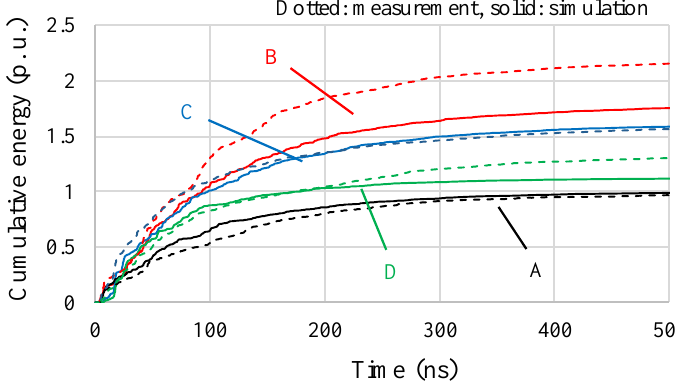
Figure 9. Simulated and measured cumulative energies as a function of the UHF sensor positions.